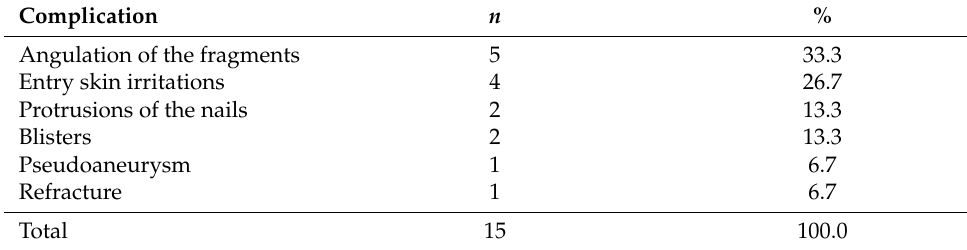
Table 4. Postoperative